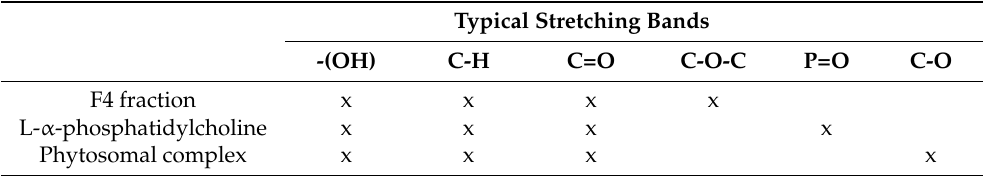
Table 1. Major FTIR bands recorded [4–7].